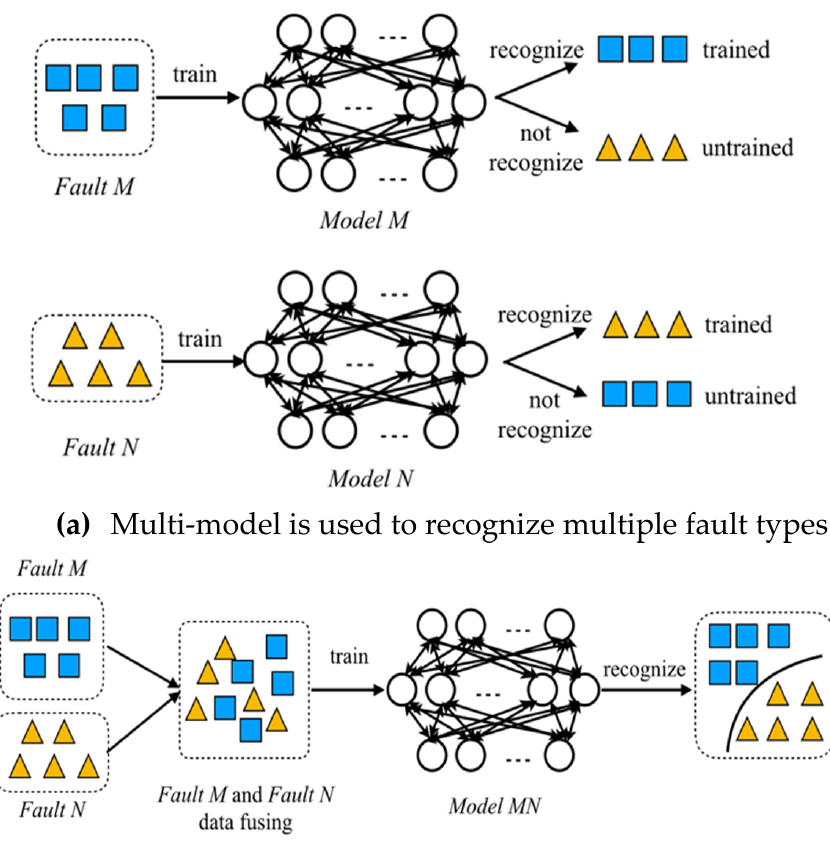
Figure 1. Existing fault diagnosis methods.